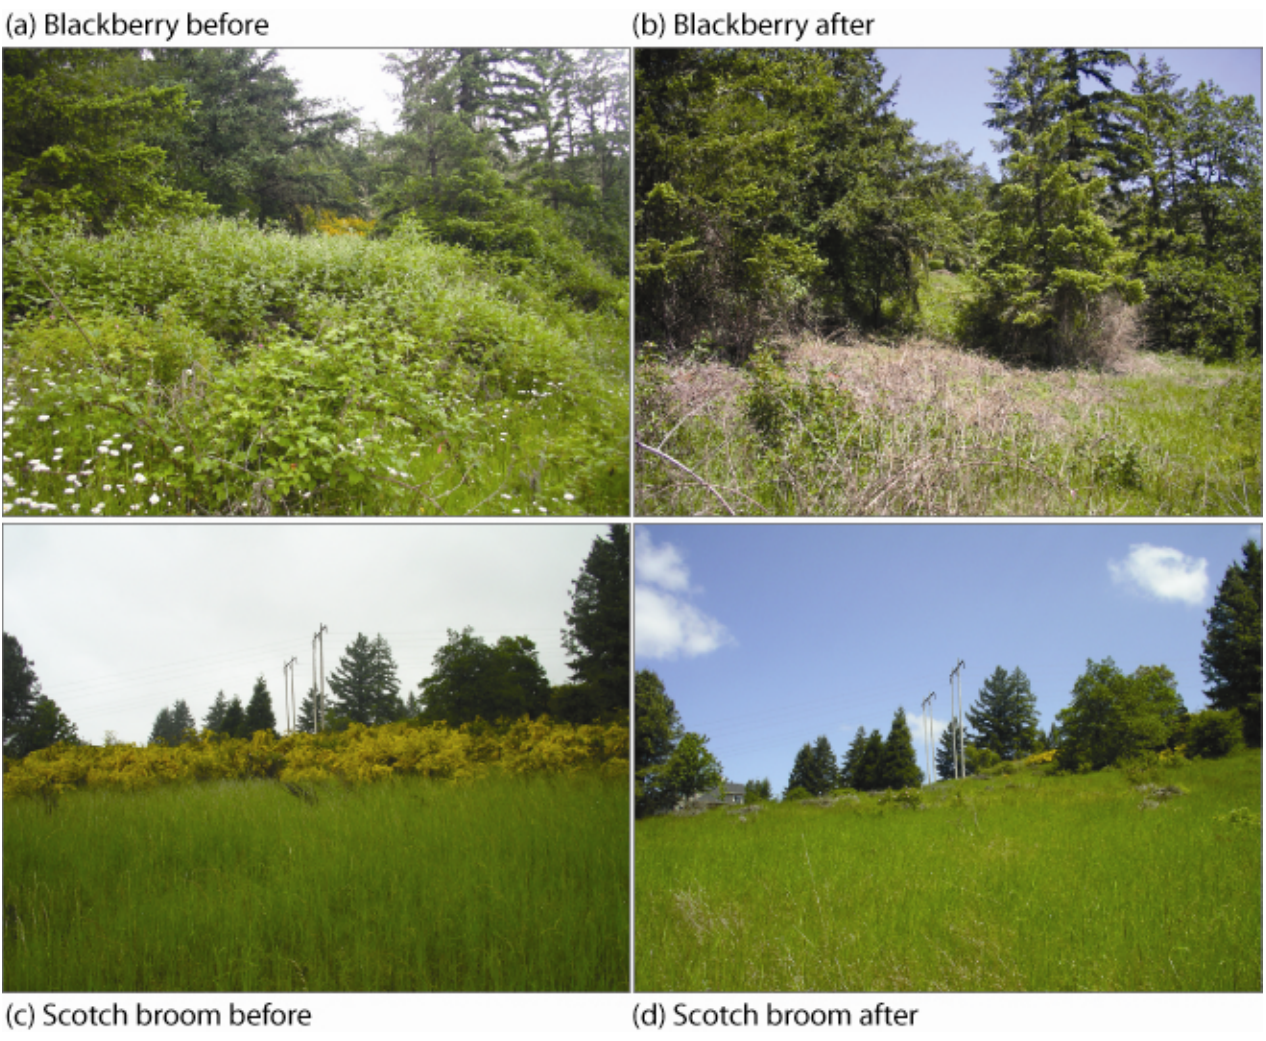
Fig. 5. Wild Iris Ridge Restoration Project. At Wild Iris Ridge, local scientists identified restoration opportunities for threatened native prairie and oak habitats. The LTWC worked with the municipal landowner to expand the scope of the project from erosion control to include 50 ha of prairie and oak habitat improvement that included blackberry removal (a and b) and scotch broom eradication (c and